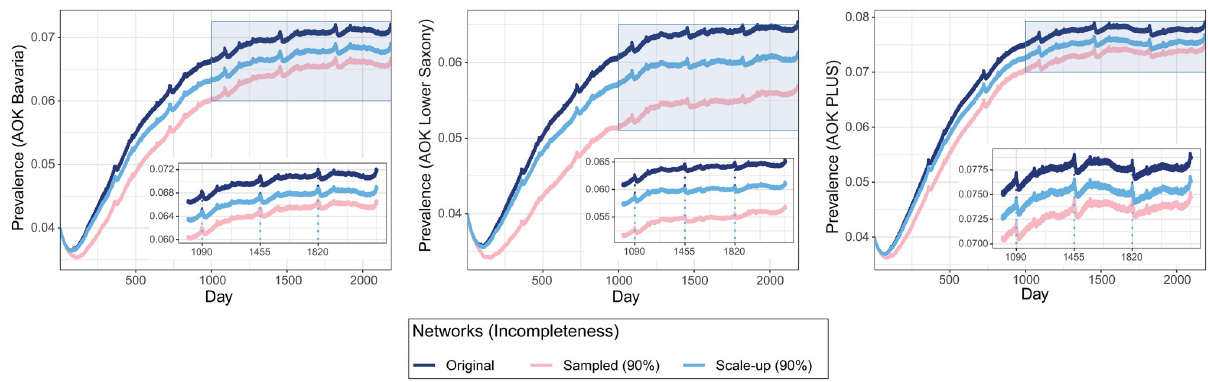
Fig 4. Prevalence in community nodes obtained from transmission model simulations for different AOK datasets. The dashed lines in each graph point the x-axis of prevalence peaks.